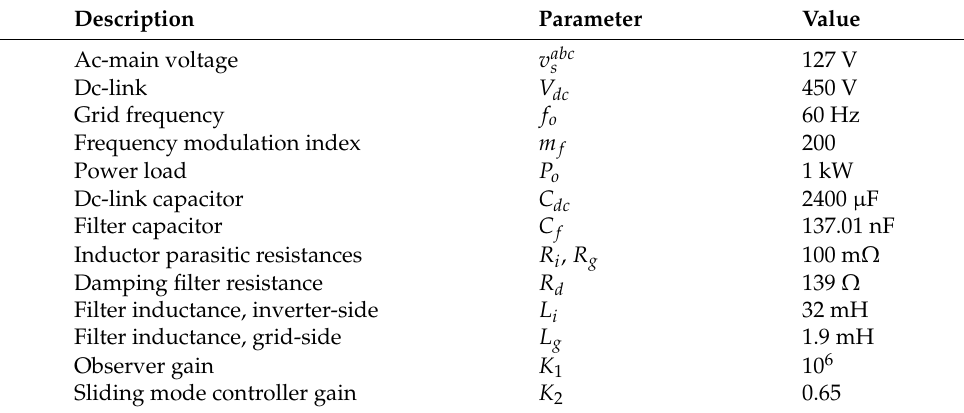
Table 1. Simulation